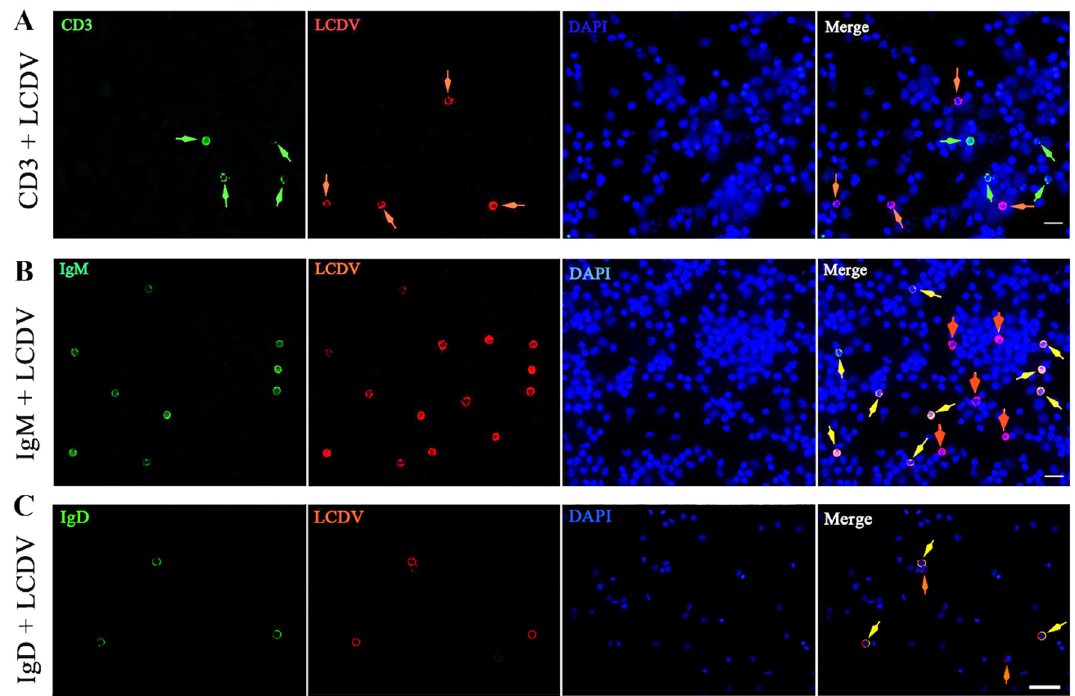
Figure 5. Co-fluorescent microscopy of LCDV + cells and CD3 + , IgM + , IgD + cells in PBLs from floun- der at 3 h post LCDV infection. ( A ) Rabbit anti-LCDV polyclonal antibody was paired with mouse anti-CD3 ε polyclonal antibody, green and red arrows indicated CD3 + T-lymphocyte and LCDV + PBLs, respectively. ( B ) Rabbit anti-LCDV polyclonal antibody was paired with mouse anti-IgM MAb, yellow and red arrows indicated LCDV + /IgM + B-lymphocytes and LCDV + /IgM − PBLs, respec- tively. ( C ) Rabbit anti-LCDV polyclonal antibody was paired with mouse anti-IgD MAb, yellow and red arrows indicated LCDV + /IgD + B-lymphocytes and LCDV + /IgD − PBLs, respectively. Cell nuclei were counterstained in blue by DAPI. Scale bar = 20 μ m.